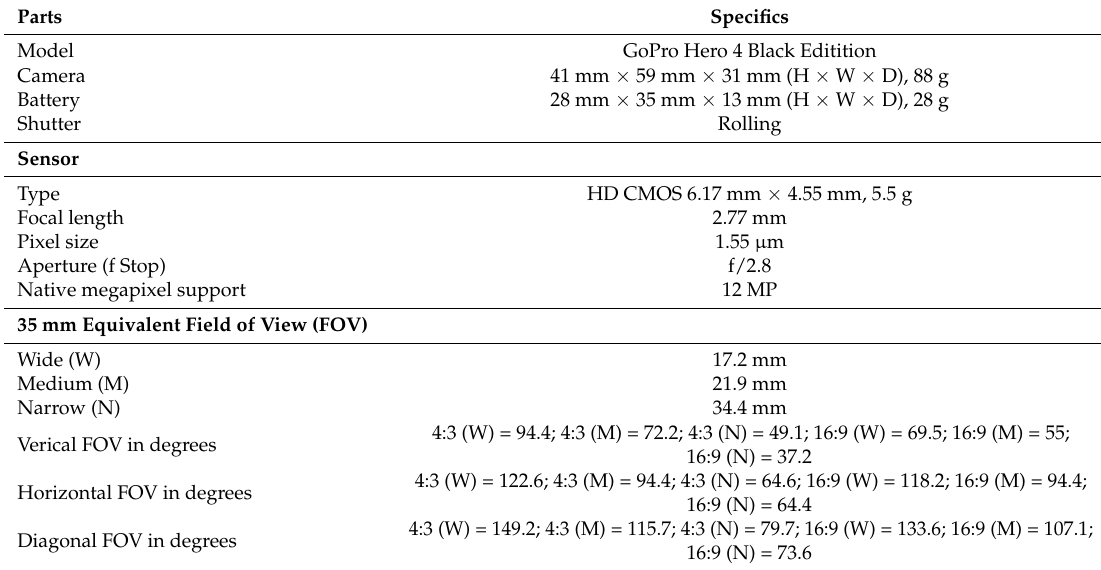
Table 1. GoPro Hero 4 black edition camera specifics and its relative field of views